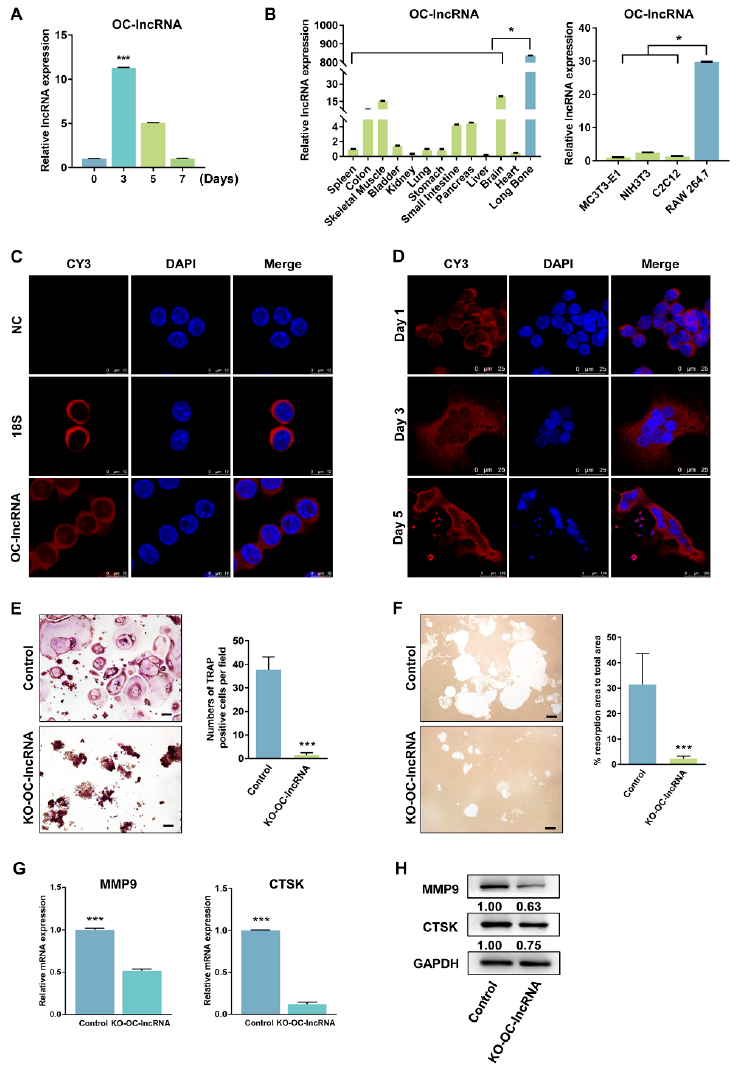
Figure 3. OC-lncRNA is an osteoclast-specific lncRNA localizing to the cytoplasm and positively regulates osteoclast differentiation. ( A ) Expression levels of OC-lncRNA in osteoclast differentiation and maturation at indicated time points. ( B ) Relative OC-lncRNA expression levels in various tissues of C57BL/6 mouse and four common mouse cell lines. ( C ) RNA-FISH for OC-lncRNA in non-treated RAW 264.7 cells. ( D ) RNA-FISH for OC-lncRNA at indicated time points of osteoclast differentiation. ( E ) TRAP staining of OC-lncRNA knock-out osteoclasts and control. Quantification of TRAP+ osteoclasts. ( F ) Representative images of bone resorption assay and quantification of resorption pits. ( G ) mRNA levels of osteoclastic genes levels detected by real-time PCR. ( H ) Osteoclastic protein levels detected by western blotting. Error bars represent SD. * p < 0.05, *** p < 0.001. 3.3. OC-lncRNA Positively Regulates Osteoclasts via a Competing Endogenous (ce)RNA Mechanism Because OC-lncRNA is localized to the cytoplasm, ceRNA was the primary consid-